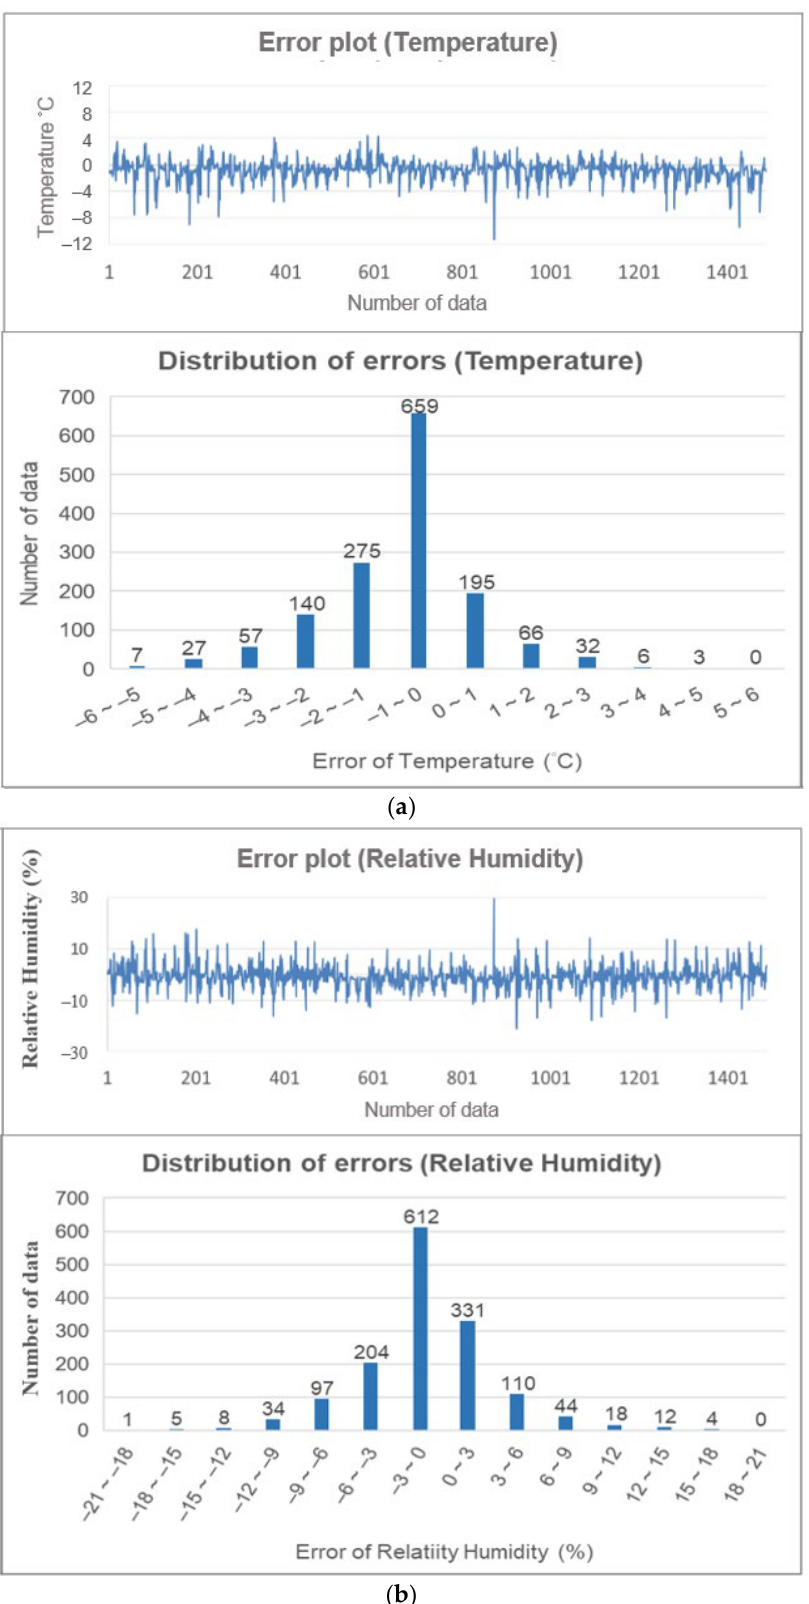
Figure 6. Errors and error distributions of greenhouse microclimate predictions from the BPNN model (20 May 2019–20 July 2019). ( a ). Internal temperature. ( b ). Internal relative humidity.